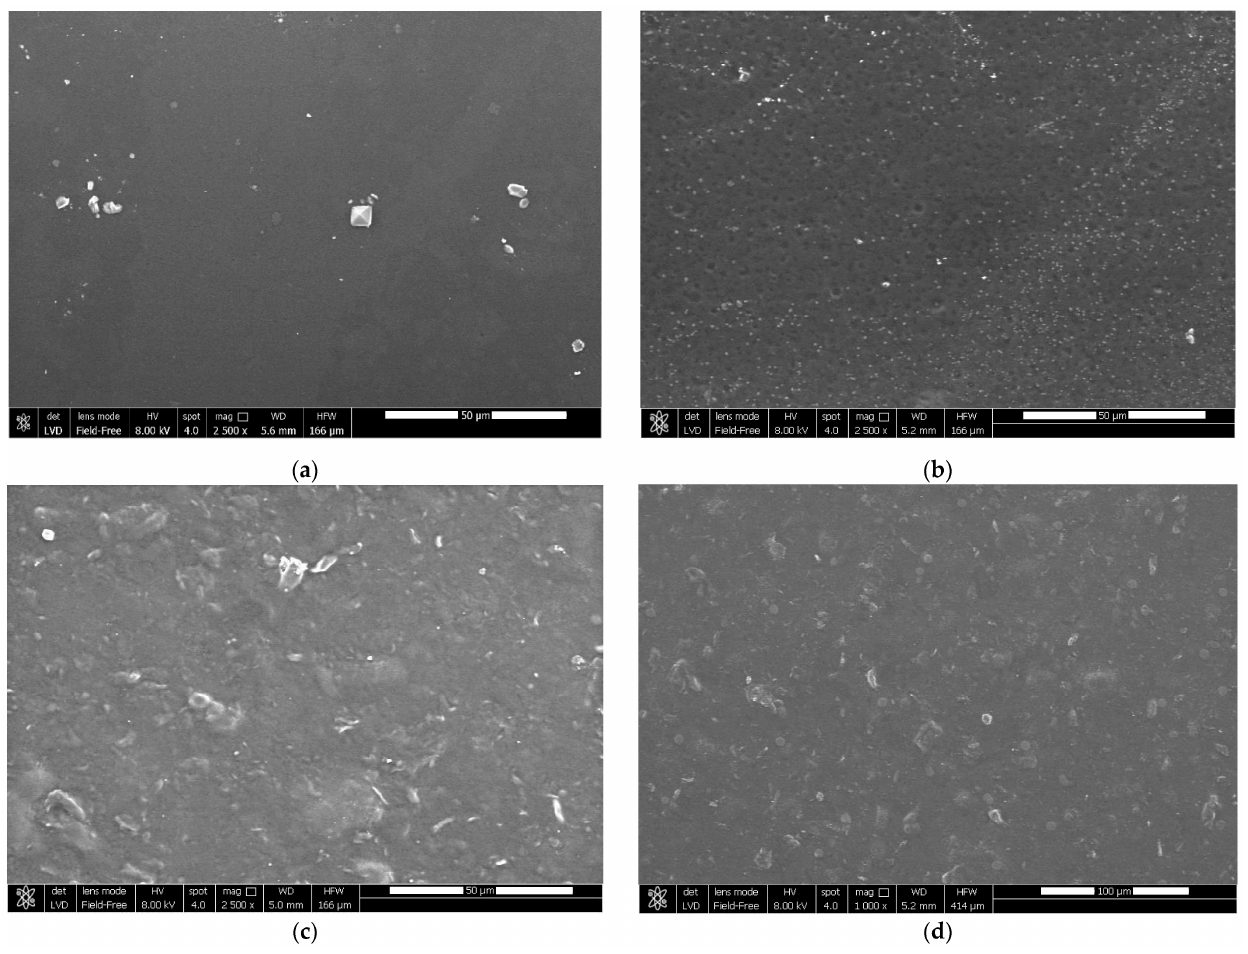
Figure 4. SEM images (surface) of films based on ( a ) chitosan/hydroxypropyl methylcellulose blend (CS/HPMC), ( b ) CS/HPMC/LAE, ( c ) CS/HPMC/CNCs, and ( d ) CS/HPMC/CNCs/LAE. The control film’s surface was homogeneous, smooth, and compact (Figure 4a).